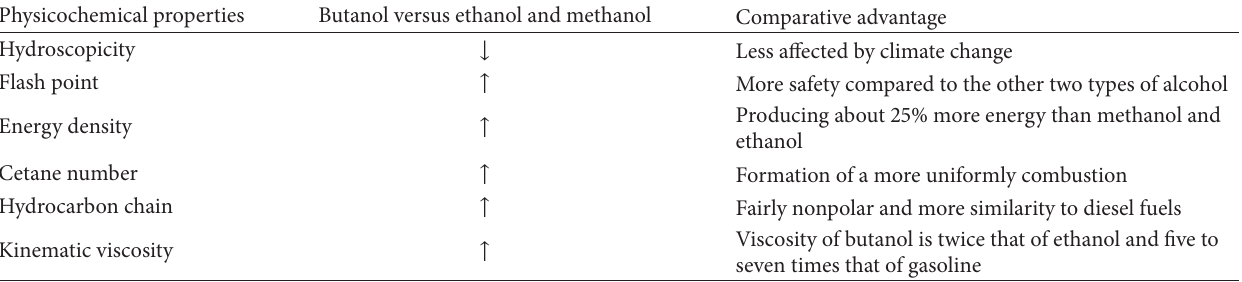
Table 1: Comparison of physicochemical characteristics of butanol, methanol, and ethanol [1, 2]. Physicochemical properties